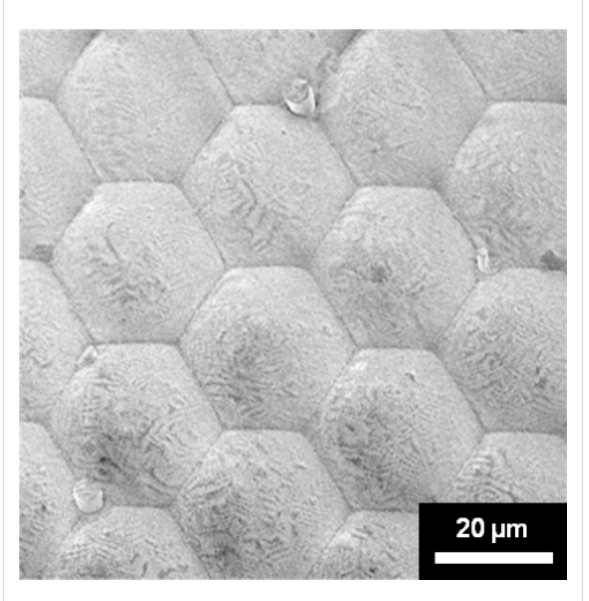
Figure 1: Scanning electron micrograph showing the facet structure of the Mourning Cloak butterfly. Note the bases of fractured hair at some of the triple junctions (magnification: